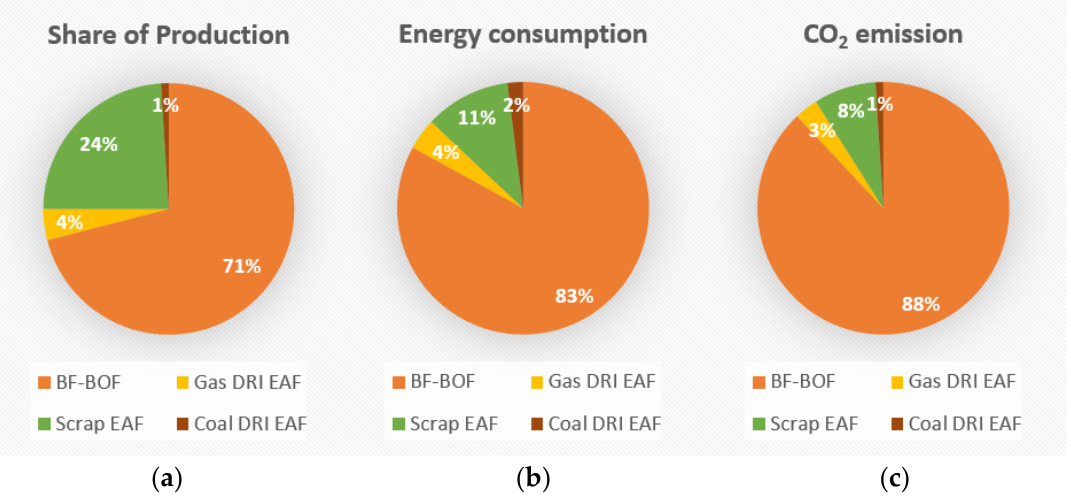
Figure 1. Share of worldwide ( a ) production, ( b ) energy consumption, and ( c ) CO 2 emission percentage via different steelmaking processes. Data from [2].